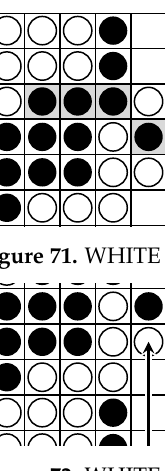
Figure 70. WHITE’s second move.